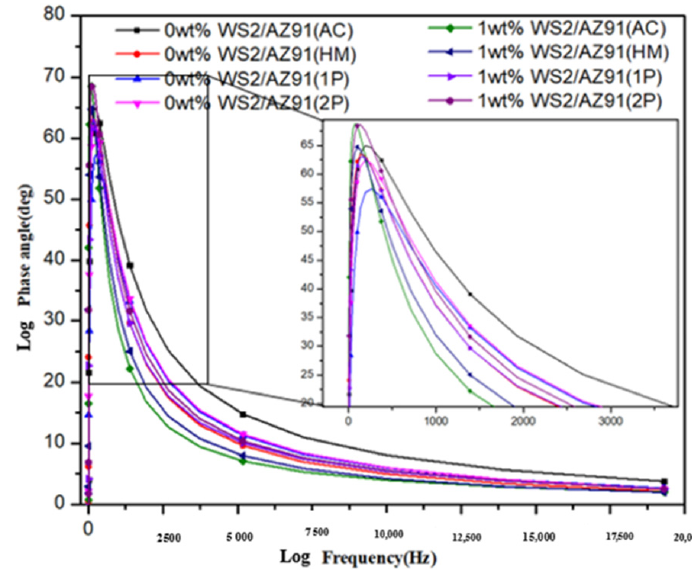
Figure 7. Comparative Bode diagrams for WS 2 /AZ91 composites.